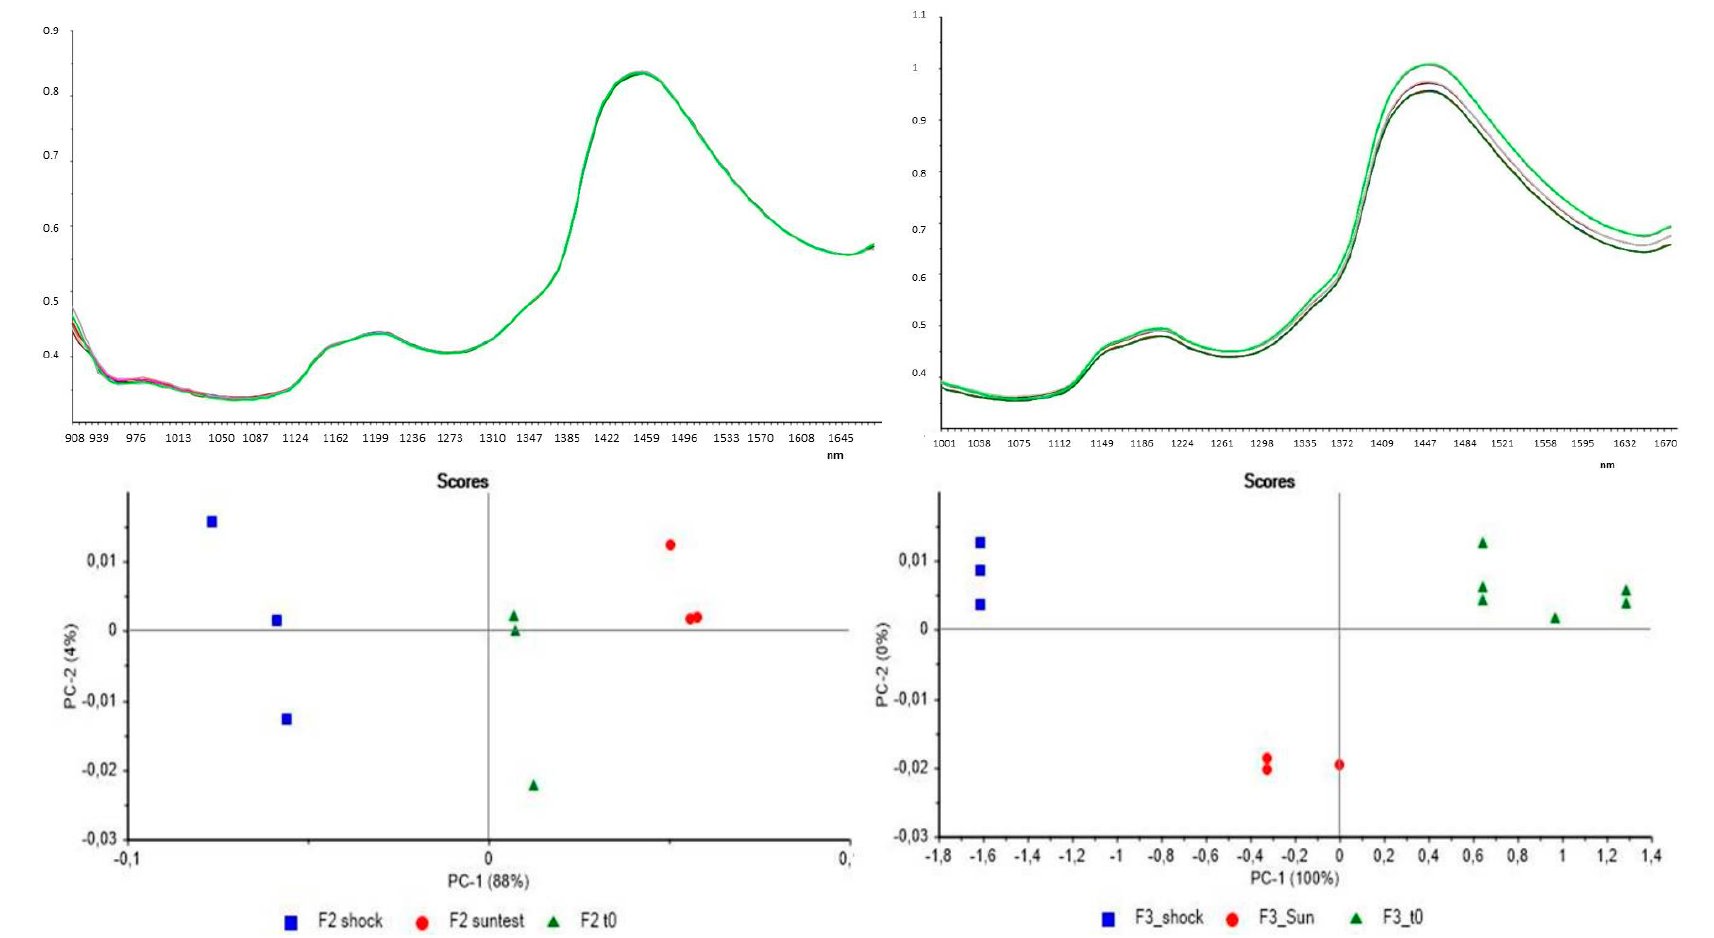
Figure 7. ( left )up: Spectra of untreated F2 sample (dark green line) F2 after shock treatment (green line) and F2 after suntest treatment (red line); down: PCA for treated and untreated F2; ( right ) up: Spectra of untreated F3 sample (dark green line) F3 after shock treatment (green line) and F3 after suntest treatment (purple line); down PCA for treated and untreated F3.